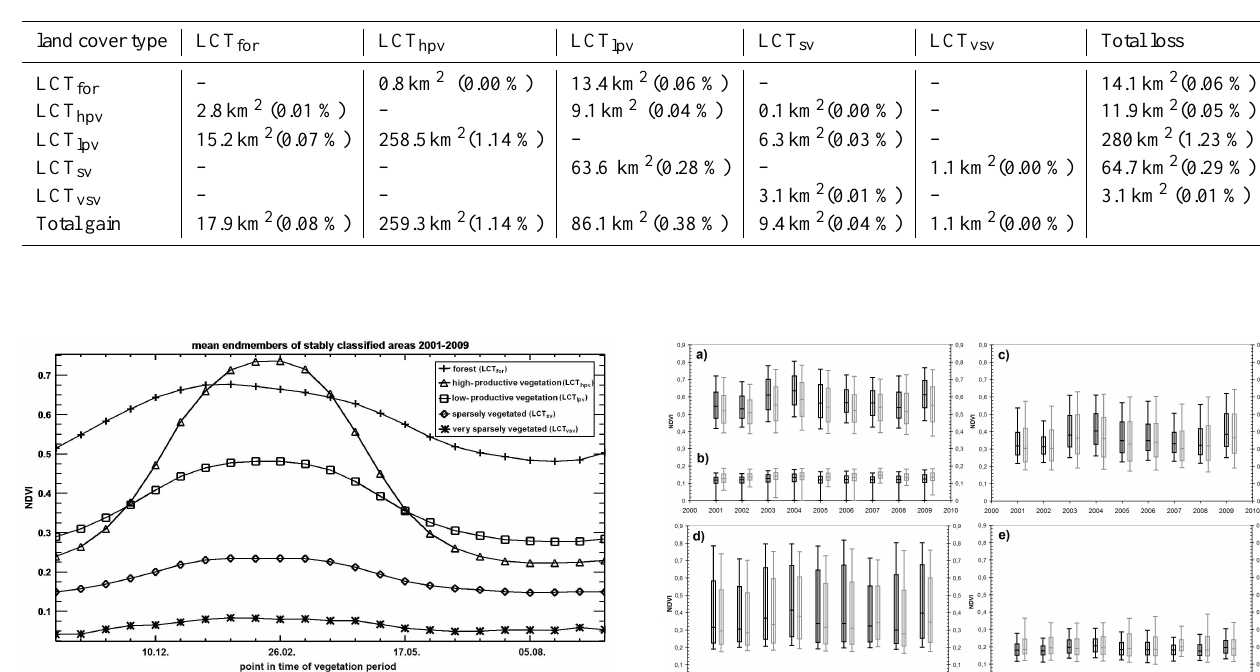
Table 3. Identified actual land cover changes (2001–2009) in total and as percentage of the study region. Columns show the gain of land cover types and rows show the loss of land cover types: LCT for (Forest), LCT hpv (High-productive vegetation), LCT lpv (Low-productive vegetation), LCT sv (Sparsely vegetated), LCT vsv (Very sparsely vegetated).